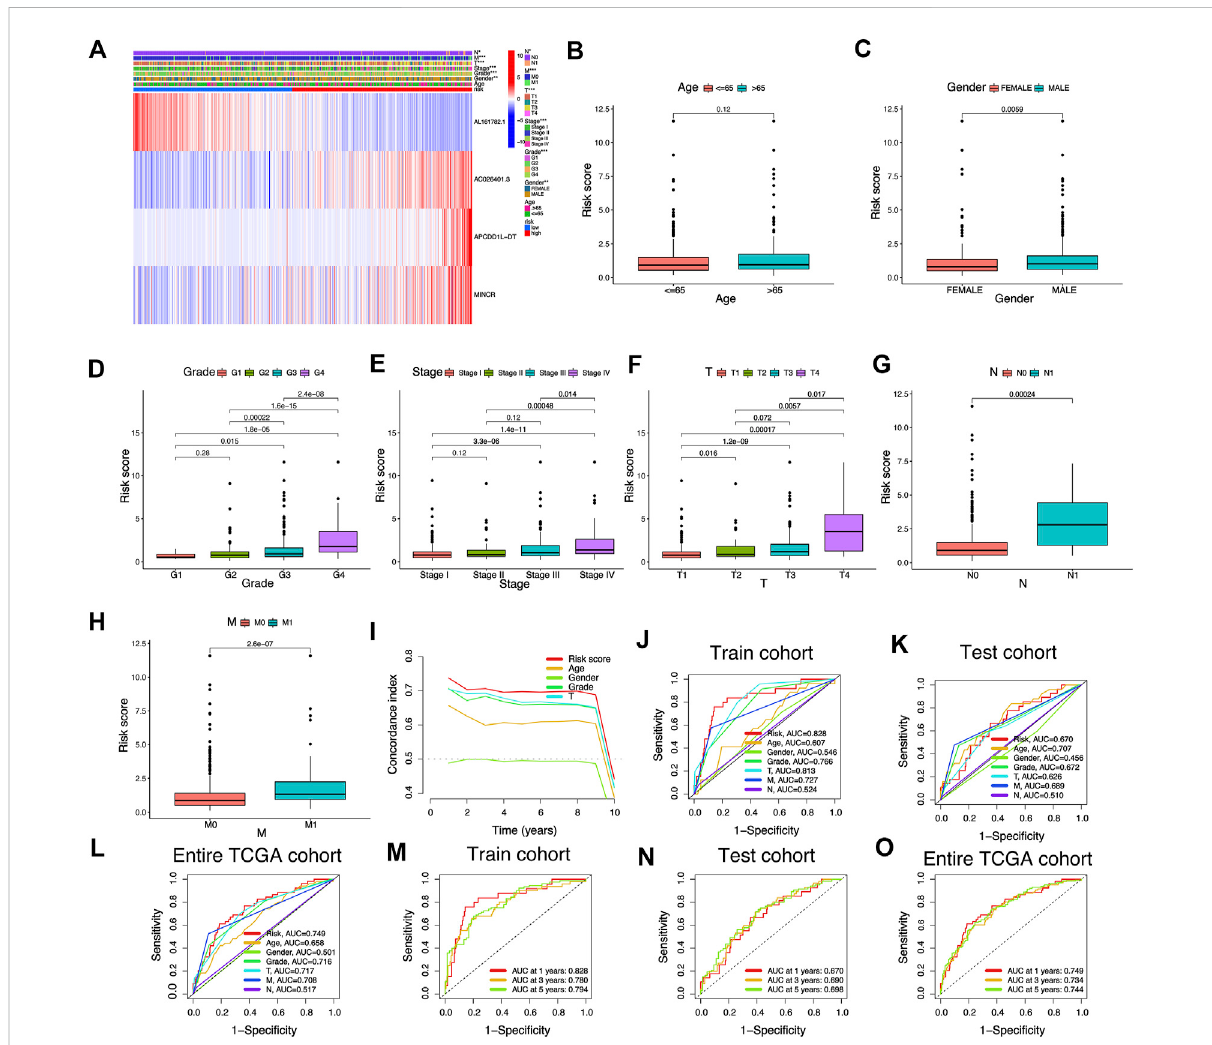
FIGURE 5 Association between risk signature scores composed of cuproptosis-related lncRNAs and clinical features. (A) The heatmap shows the clinical characteristics and expression of 4 risk cuproptosis-related lncRNAs in 530 KIRC patients. (B – H) Differential distribution of risk scores among KIRC patients with different clinical characteristics. (I) The consistency index showed that the risk score was better than other clinicopathological features in predicting the prognosis of KIRC patients. (J – O) ROC curves for risk signature composed of cuproptosis-related lncRNAs in Train cohort, Test cohort, and Entire TCGA